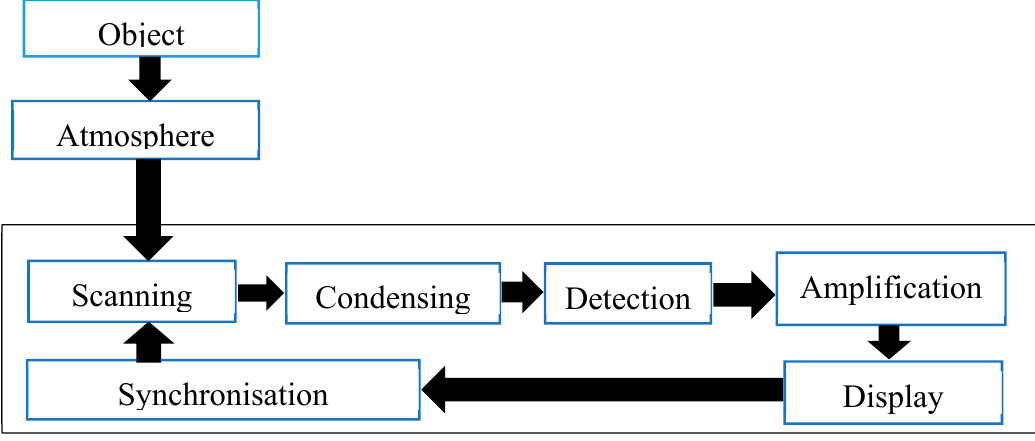
Figure 5. Basic functions of a IR thermography camera [30].